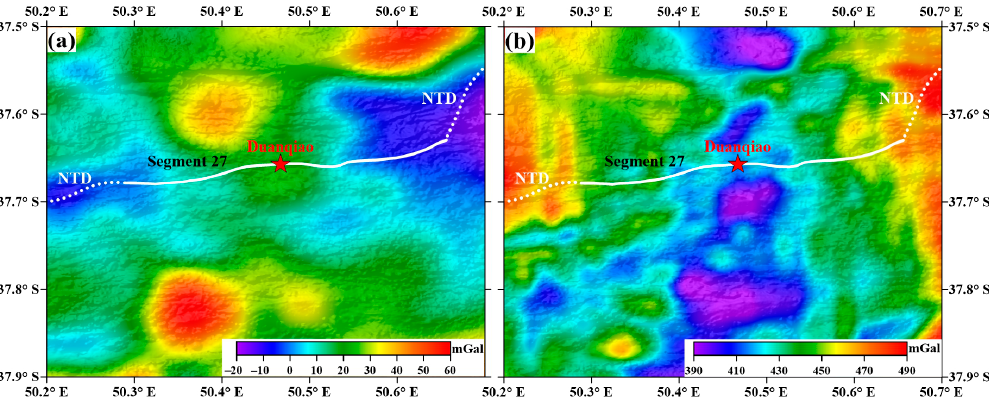
Figure 4. ( a ) Free air gravity anomaly based on ship-borne gravity data and ( b ) complete Bouguer gravity anomaly calculated by subtracting the gravity effect of terrain from the free air gravity anomaly. The solid white line and dotted white lines represent segment 27’s axis and two NTDs, respectively. The red star denotes the Duanqiao hydrothermal field [17].